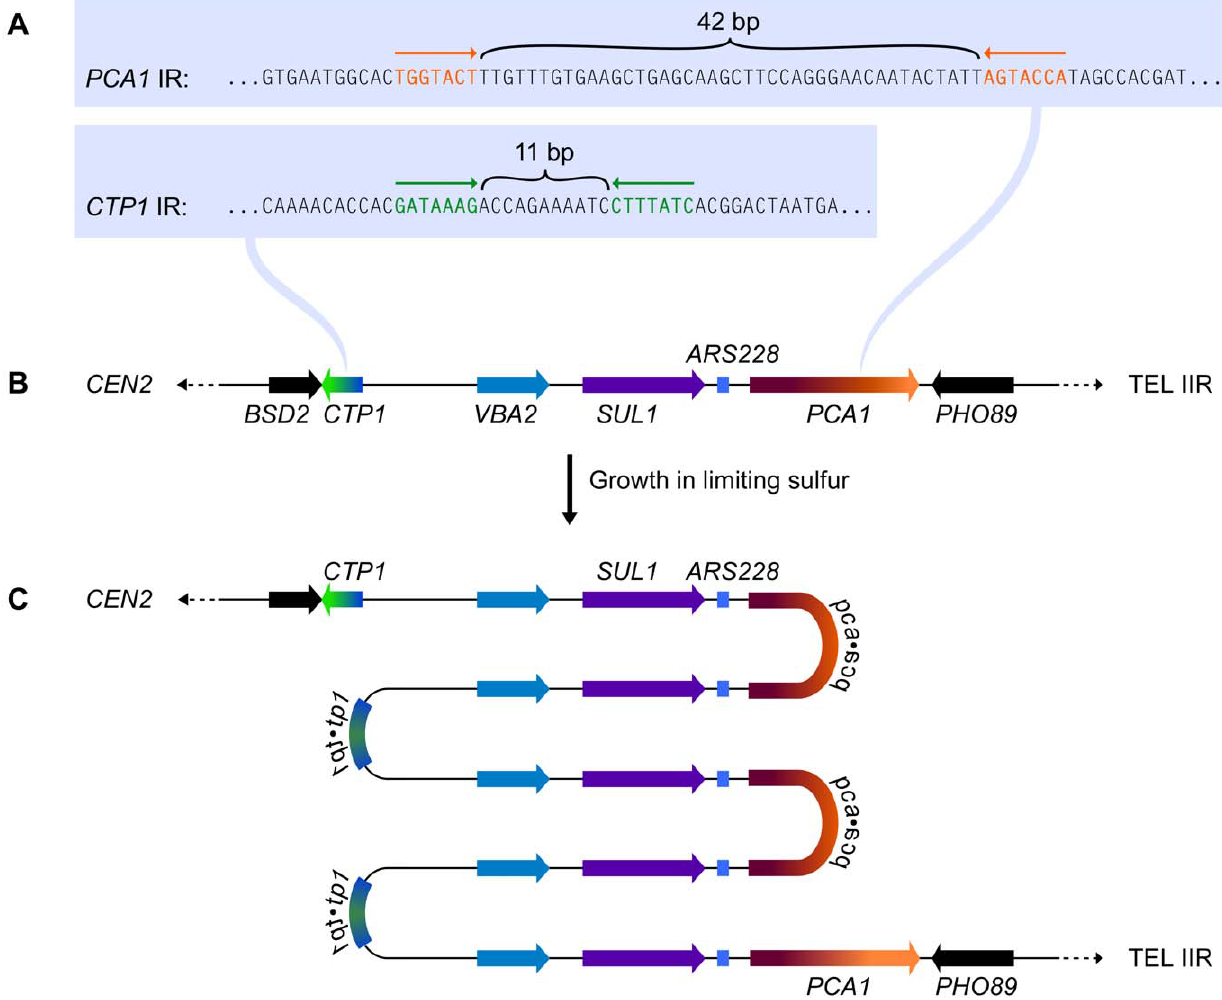
Figure 1. The chromosomal context for SUL1 amplification. (A) The inverted repeat sequences in CTP1 and PCA1 that define the breakpoints of a specific SUL1 amplification event [7]. (B) The structure of the wild type SUL1 locus that includes the nearby origin of replication, ARS228 . (C) The inferred structure of the head-to-head/tail-to-tail 5 6 SUL1 amplification product recovered after selective growth of a haploid yeast strain in medium limiting for